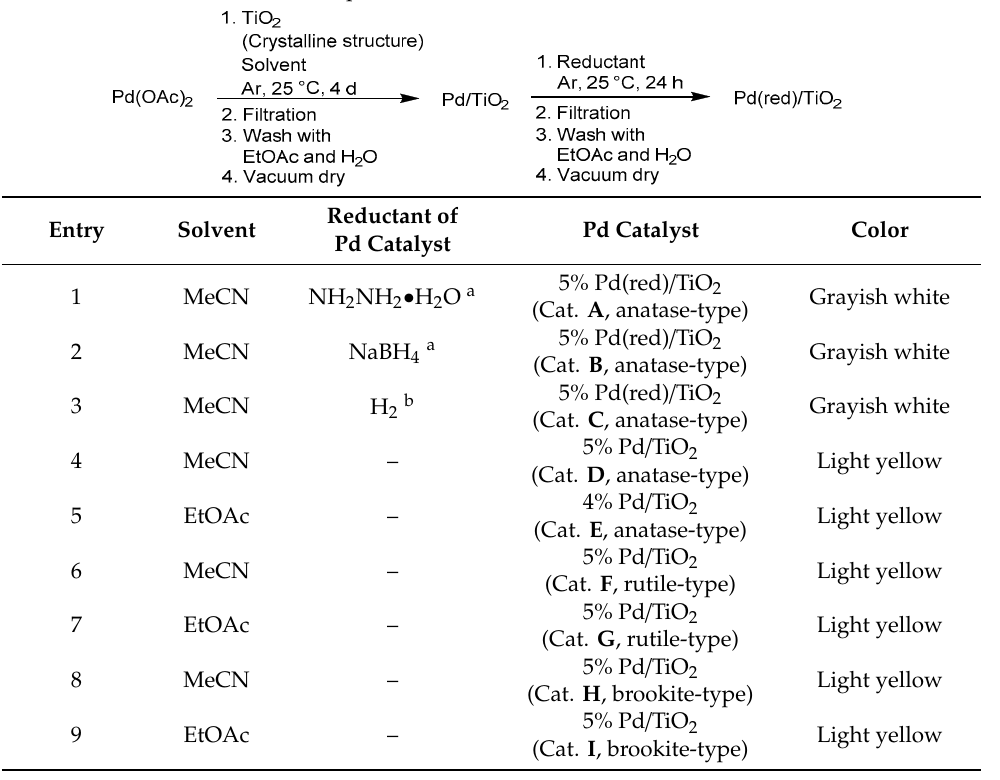
Table 1. Preparation of Pd/TiO 2 and Pd(red)/TiO 2 .